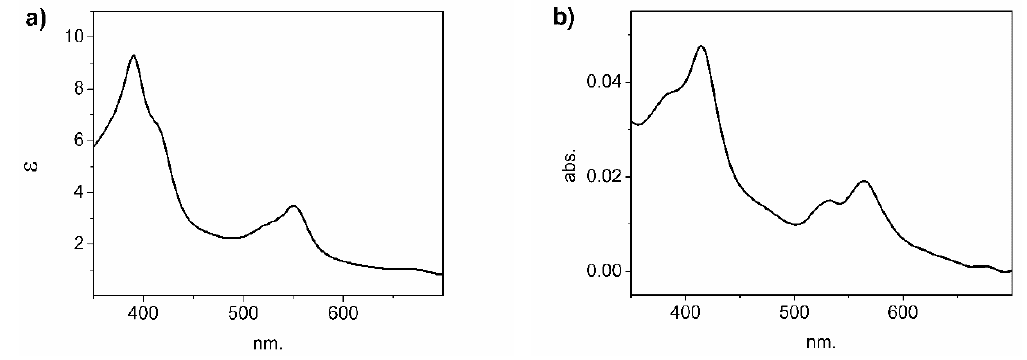
Figure 4. UV-vis spectra ( a ) in solution and ( b ) in solid, of 0.025 mM cobalt octaethylporphyrin in DCM/hexane 2:8.